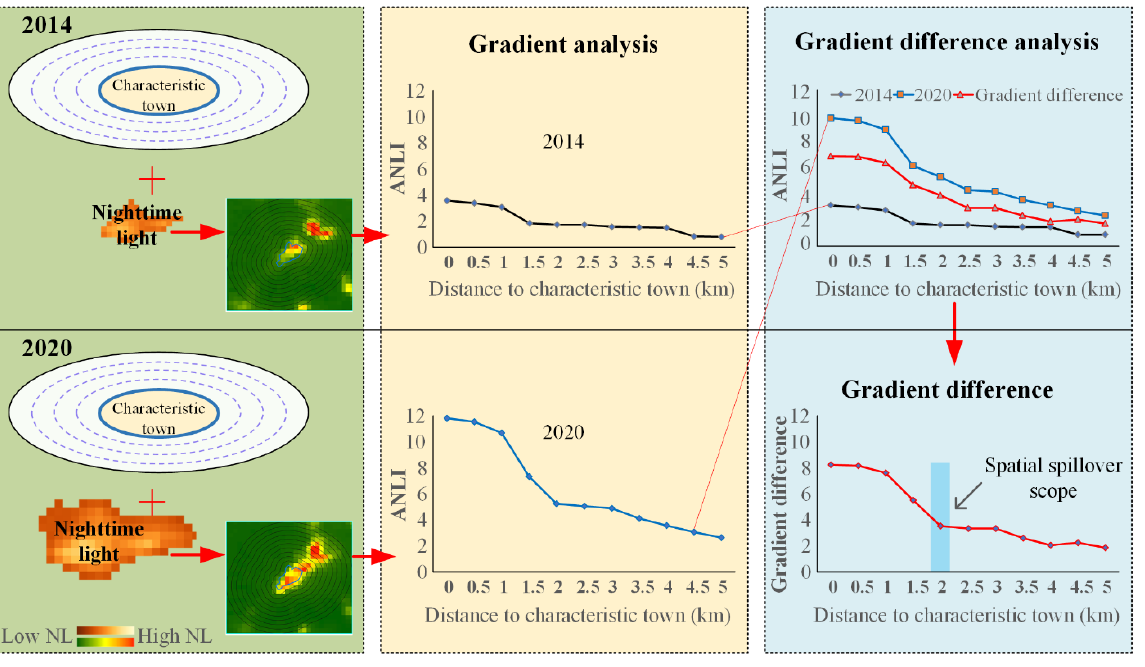
Figure 2. The analytical framework.